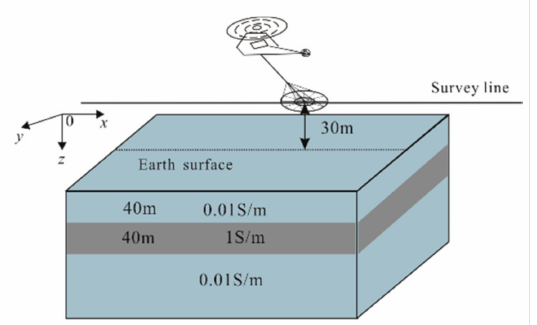
Figure 1. Airborne electromagnetic (AEM) system over a 3-layer earth.